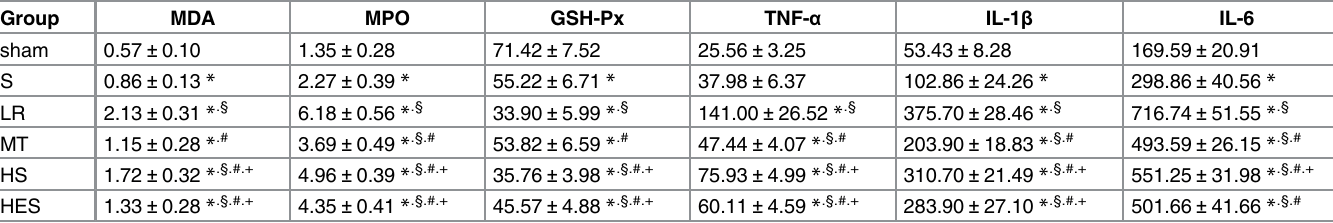
Table 2. Intestinal inflammatory and oxidative injury mediators in each group.